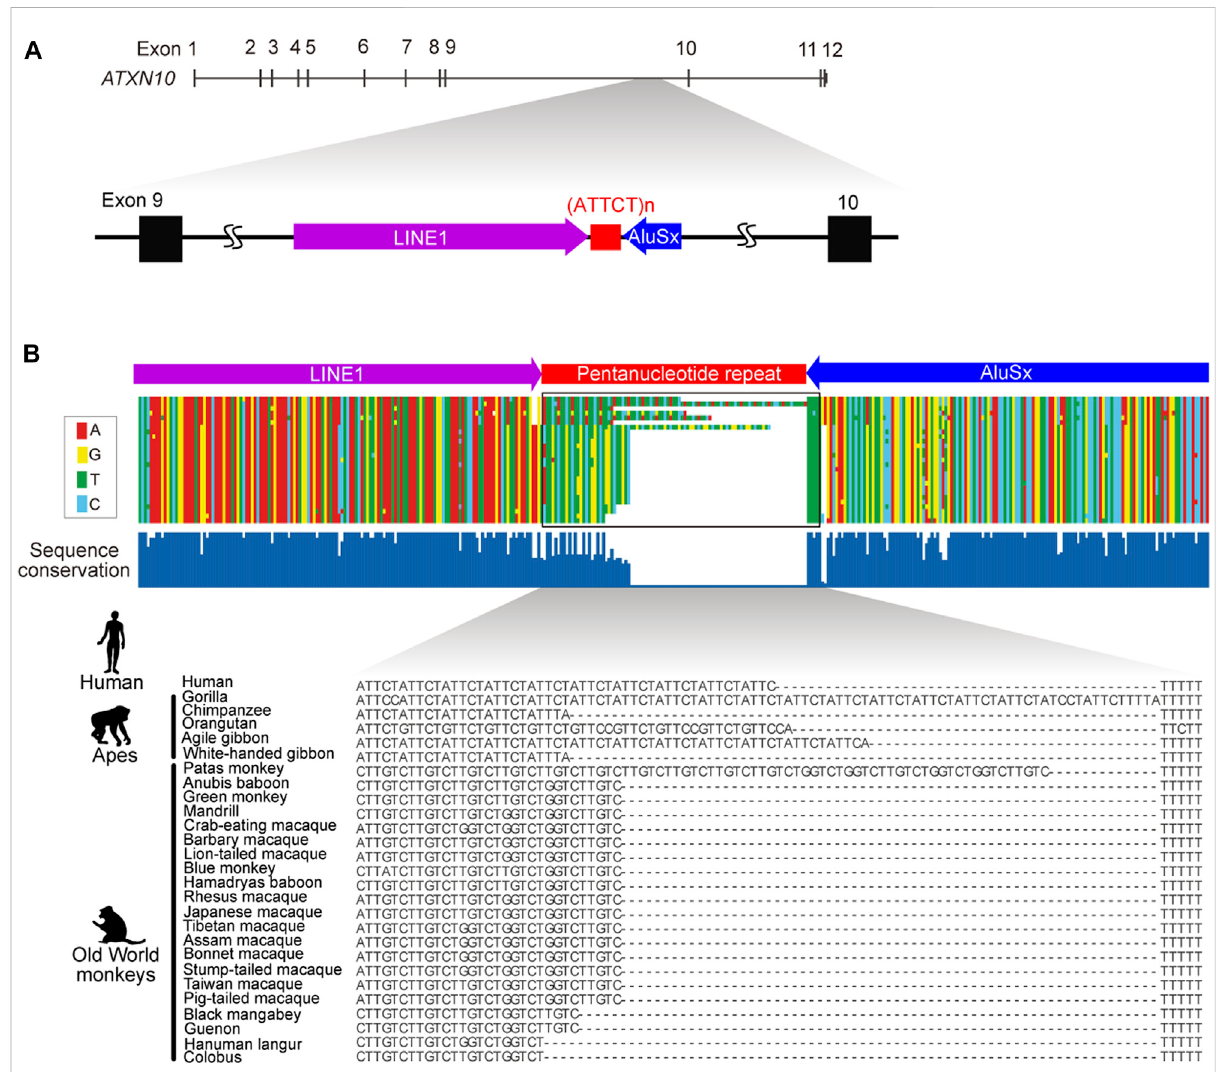
FIGURE 1 Genomic structure of ATXN10 pentanucleotide repeats. (A) The genomic location of the ATTCT pentanucleotide repeat between transposable LINE1 and the AluSx element in human ATXN10 intron 9. (B) Multiple alignments comparing ATXN10 pentanucleotide repeats in primate species using sequence data from Kurosaki et al.,